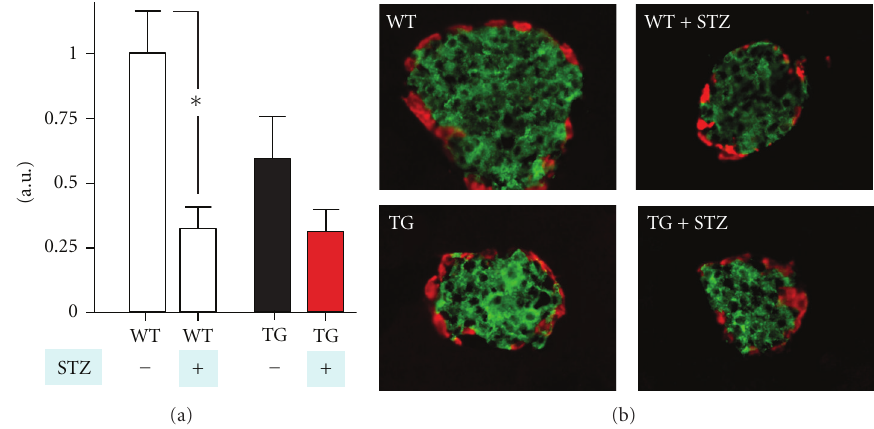
Figure 4: Quantification of the β -cell area in pancreatic islets by immunohistochemistry . (a) WT mock-treated mice (empty bars − STZ) n = 7 and tetGPR39/RIP-rtTA transgenic (TG) mock-treated mice (black filled bars − STZ) n = 6. WT STZ treated (empty bars + STZ) n = 5, tetGPR39/RIP-rtTA transgenic (TG) STZ-treated mice (red filled bars + STZ) n = 5. ∗ P < 0 . 05 (Mann-Whitney t -test). (b) Representative islets stained with anti-insulin (green) and anti-glucagon antibodies (red). a.u.: arbitrary